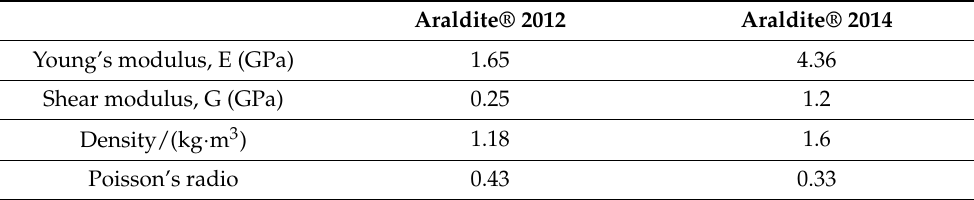
Table 3. Araldite® 2012 and 2014 parameters.